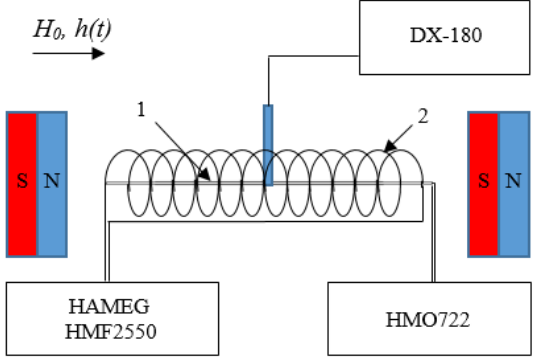
Fig. 2. The scheme of the measuring unit and the direction of the magnetic fields: 1-magnetopiezofiber; 2-modulating